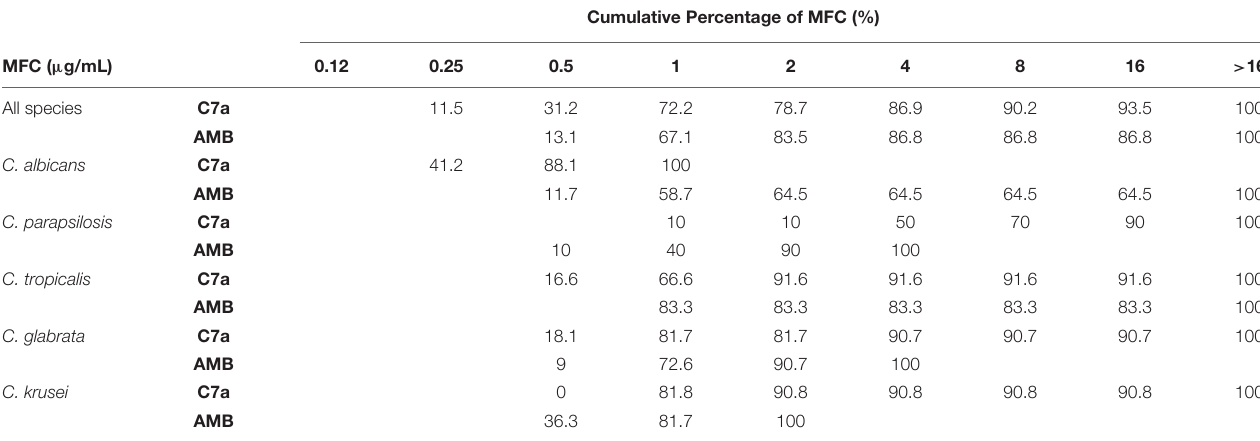
Results represent the percentage of isolates showing total growth inhibition at each compound concentration. All species, represents the combination of all clinical isolates in this study.